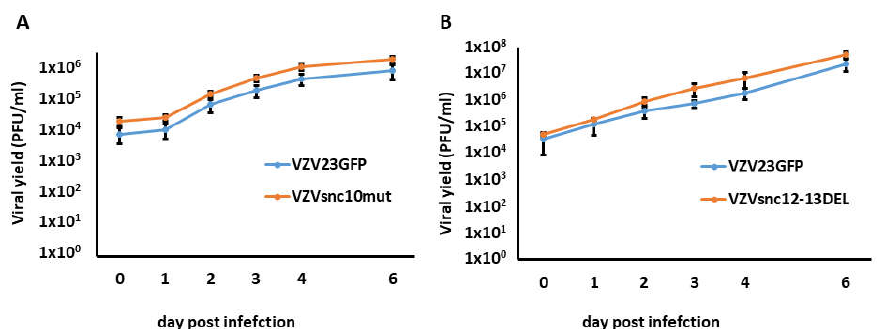
Figure 3. VZVsnc10MUT or VZVsnc12-13DEL growth curves compared to VZVGFP23 in lytically infected ARPE-19 cells . ARPE19 cells were infected with VZVsncRNA10mut or VZVsnc12-13DEL debris [5] and subsequently harvested from one well by trypsinization. Cells were then serially di- luted and titrated for time 0 (0 h) or subsequent times into fresh monolayers of ARPE-19 cells. At 7 dpi, the cells were fixed and stained for 30 min, and the plaques were counted on dried and stained plates to give values of viral yield in PFU. ( A ) Represents the growth of VZV23GFP compared to VZVsncRNA10mut and ( B ) represents the growth of VZV23GFP compared to VZVsnc12-13DEL. n = 3 independent experiments for each mutant virus. n = 3 independent experiments for each mutant